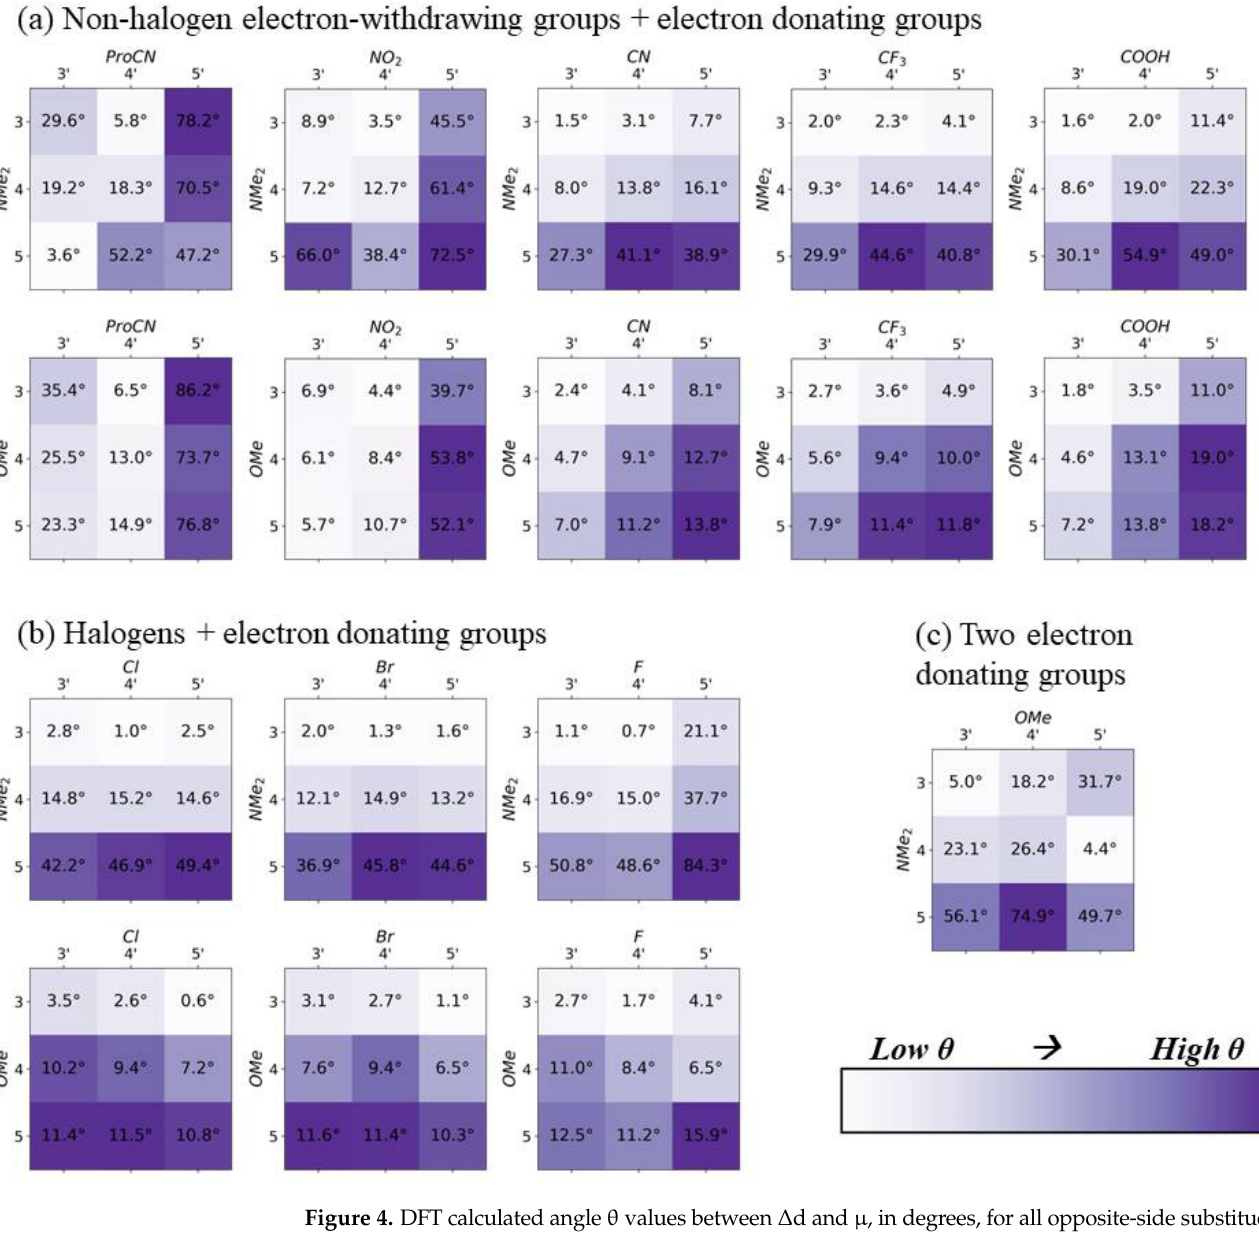
Figure 4. DFT calculated angle θ values between ∆ d and µ , in degrees, for all opposite-side substituent pairs. Darker purple indicates a larger θ . All calculations were performed with implicit solvation in water, using the integral equation formalism polarizable continuum model (IEFPCM) method (see more details in the methods section). Darker colors indicate higher values. The color range is only consistent for each substituent pair, and color-coding should not be used to compare values between pairs.